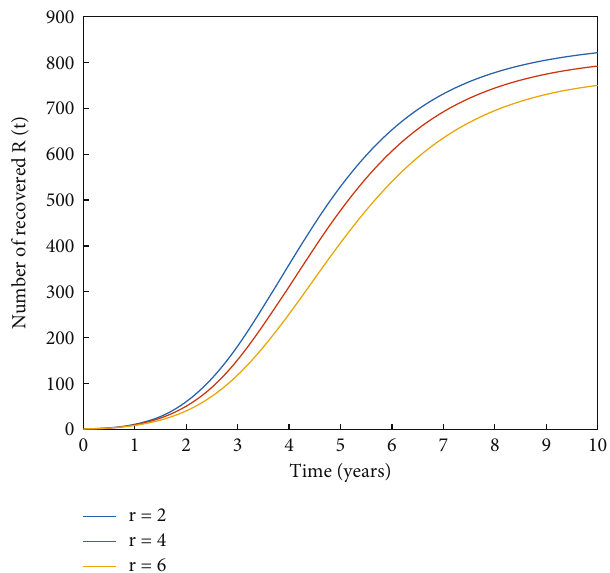
Figure 19: Transformation of recovered individuals for constant injecting rate of UV index r with various values.